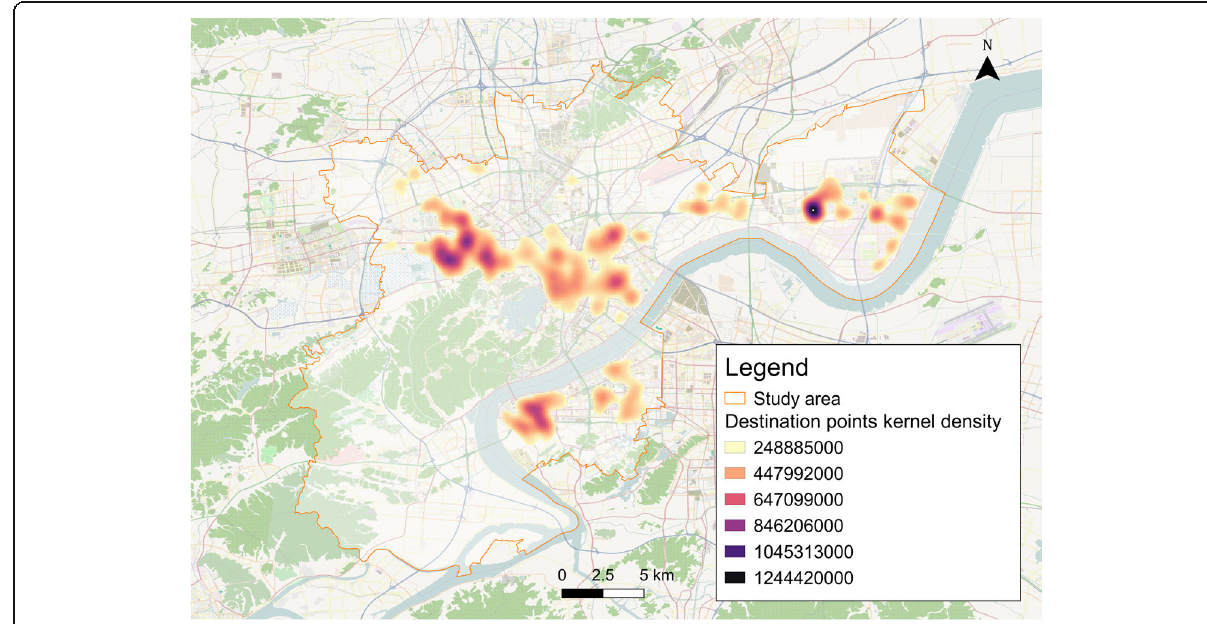
Fig. 3 Kernel density map of destination points in the study area